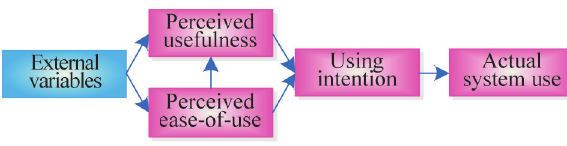
Figure 2. Technology acceptance model